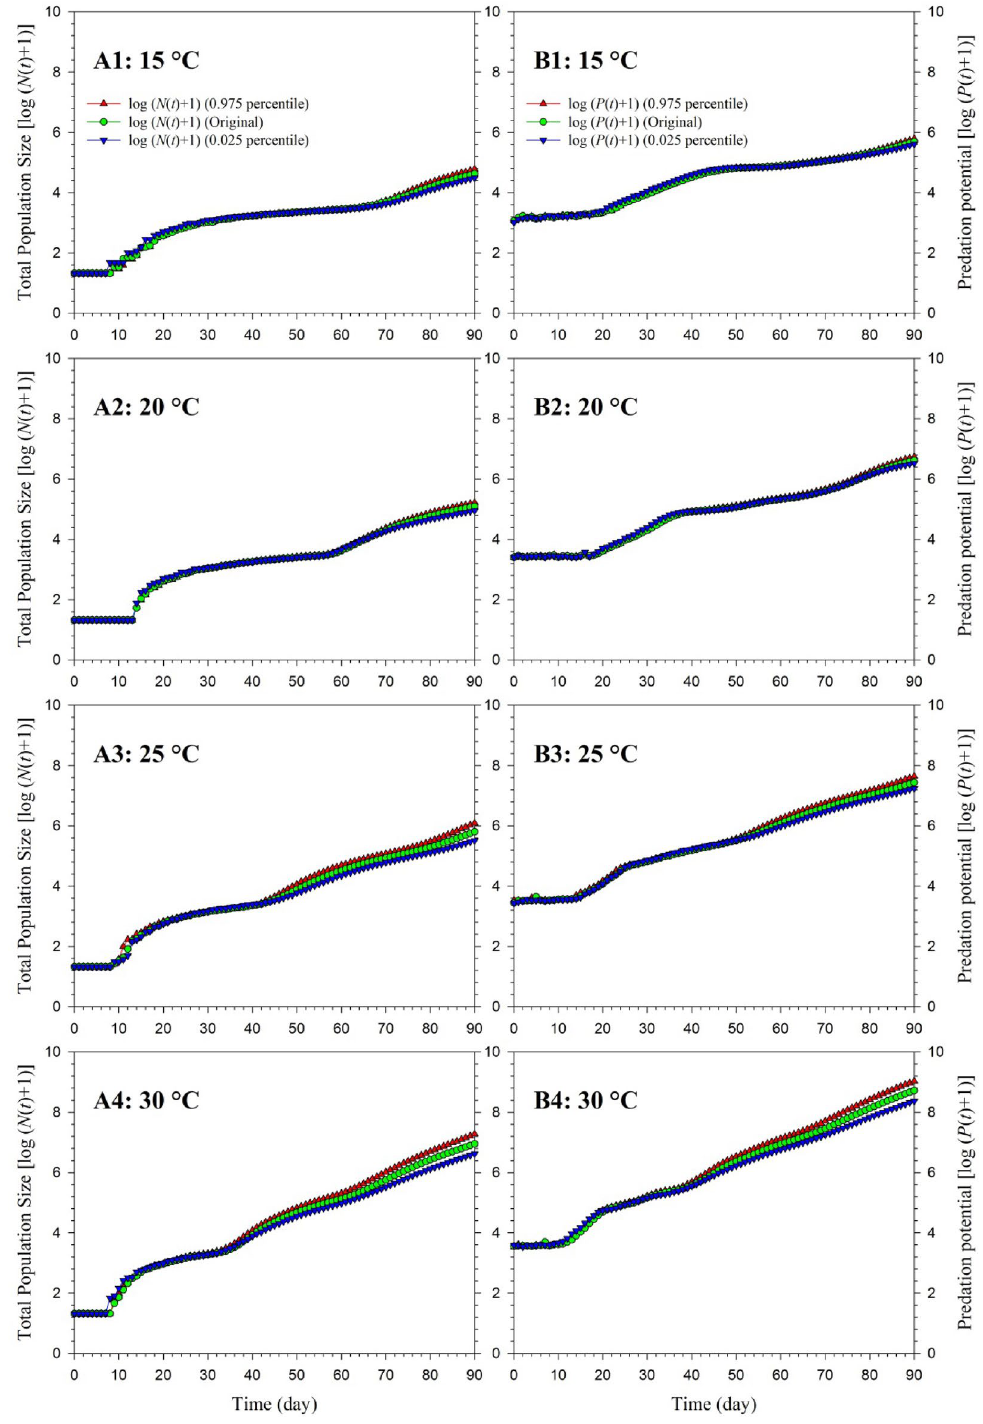
Figure 3. Population and predation projection over a 90-day period of Harmonia axyridis feeding on Spodoptera litura eggs at different temperatures (the original cohort and the cohorts constructed based on the 2.5 and 97.5% percentiles of λ, finite rate of increase are all in log base